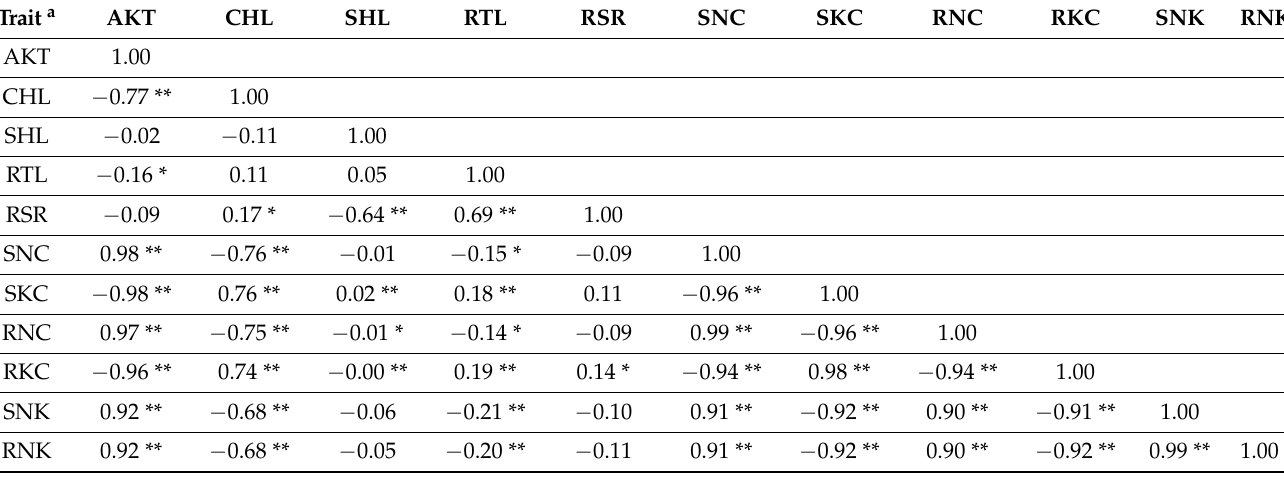
Table 2. Pearson correlation matrix of phenotypic traits measured in the Cocodrie × N22 RIL population at the seedling stage under alkaline